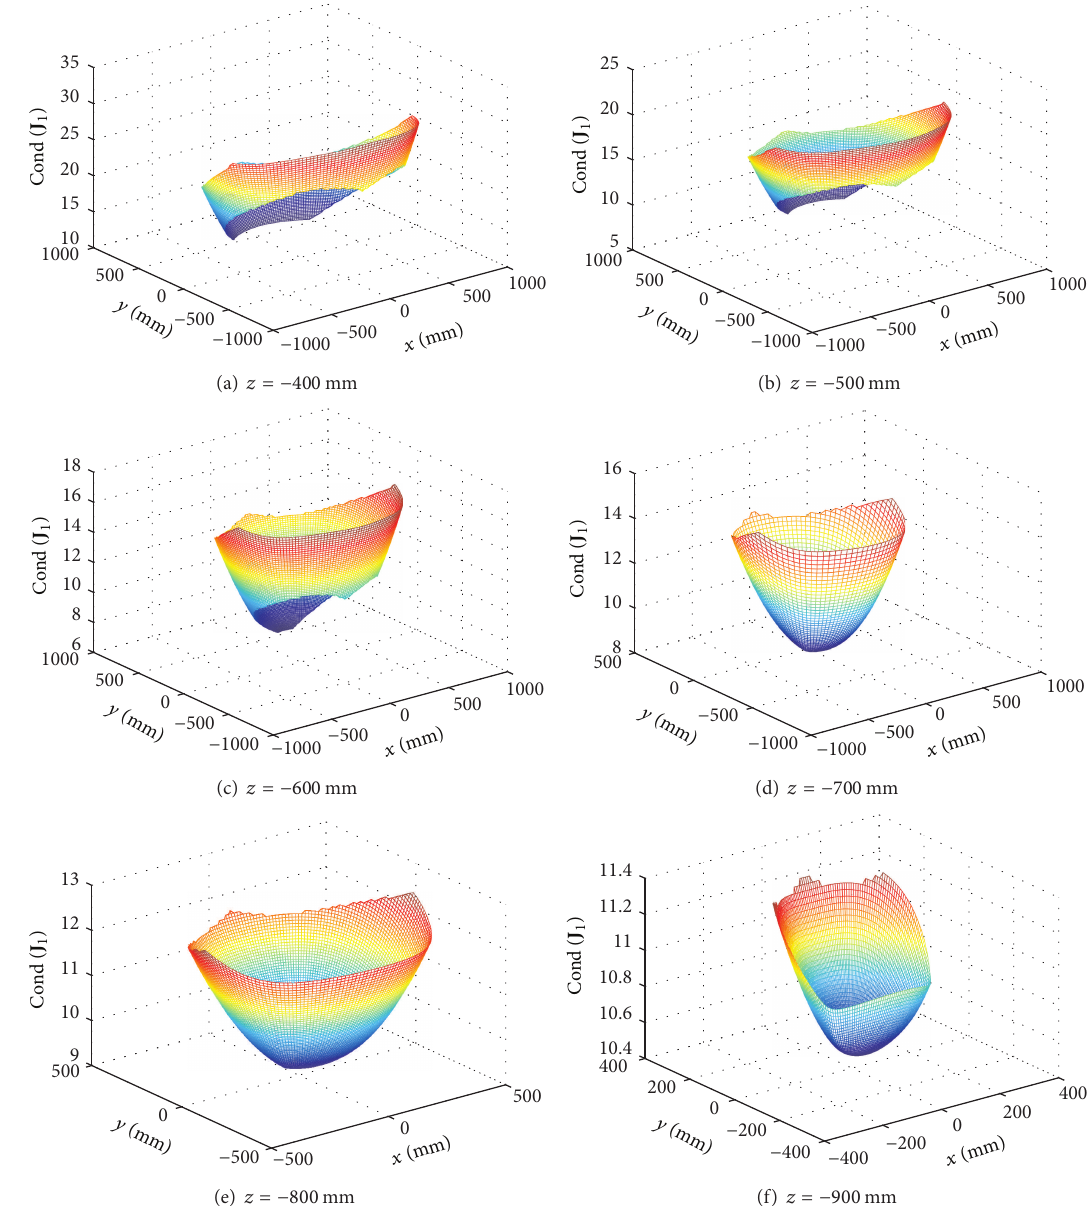
Figure 6: Changes of Jacobian matrix of the condition number in the reachable